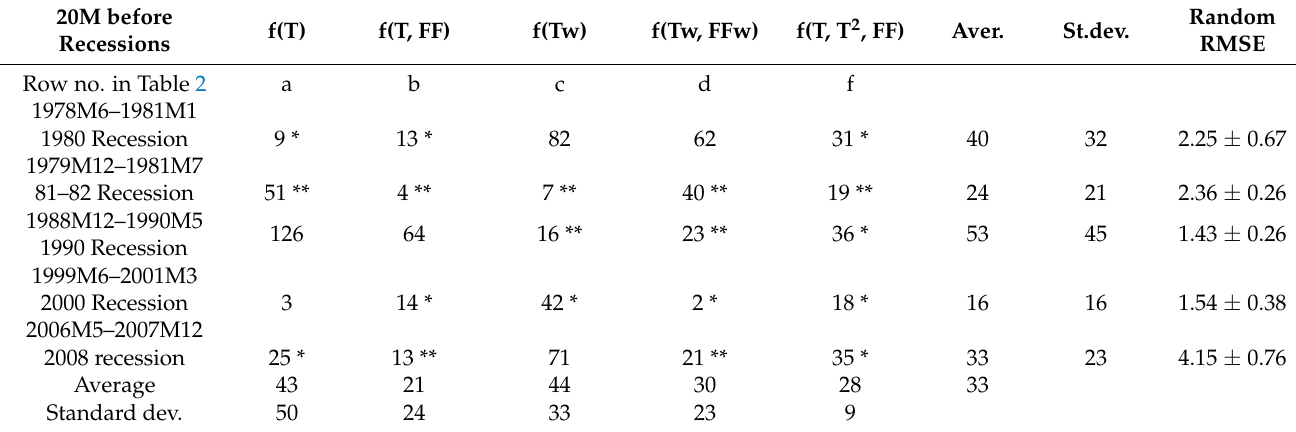
Table 3. Root mean square errors for the recession forecasts as percent of the test values in the rightmost column. 20M